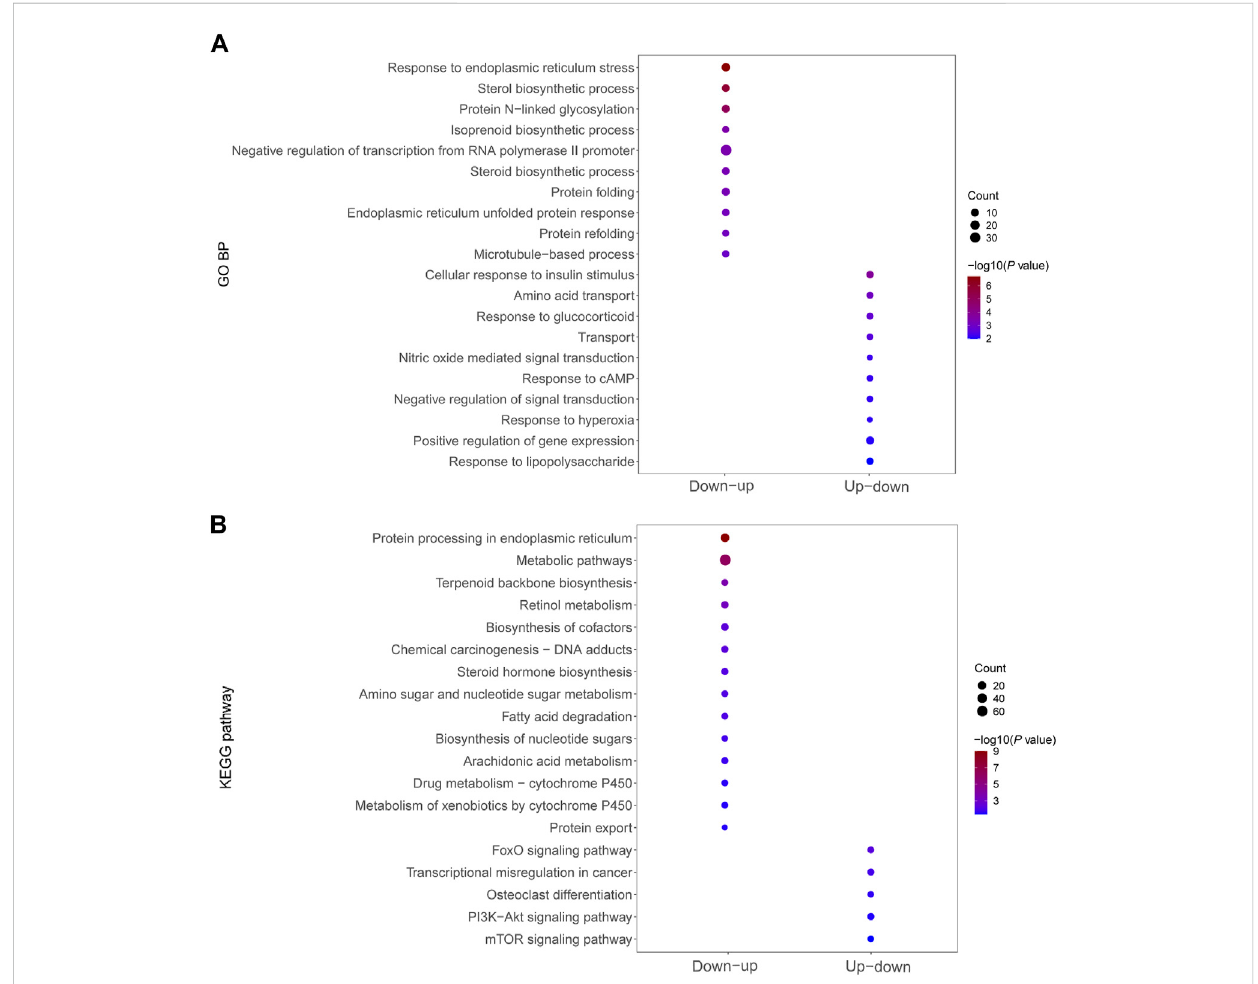
FIGURE 5 Functional enrichment of dysregulated mRNAs in signi fi cant mRNA clusters. (A) GO analysis of dysregulated mRNAs down – up/up – down in the Fed – Fast – Refed cycle. (B) KEGG signaling enrichment analysis of dysregulated mRNAs down – up/up – down in the Fed – Fast – Refed